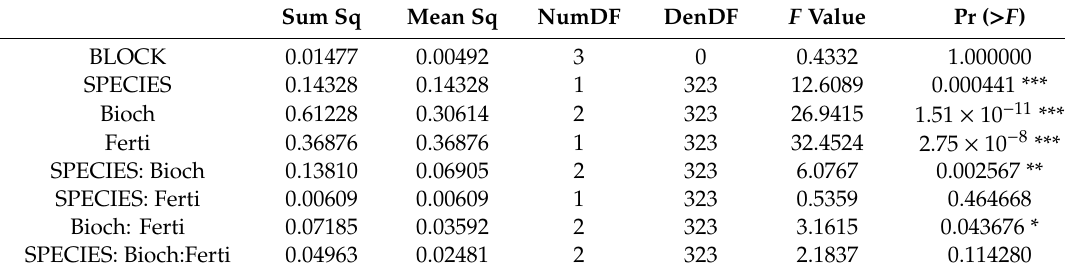
Table A10. Above-Ground